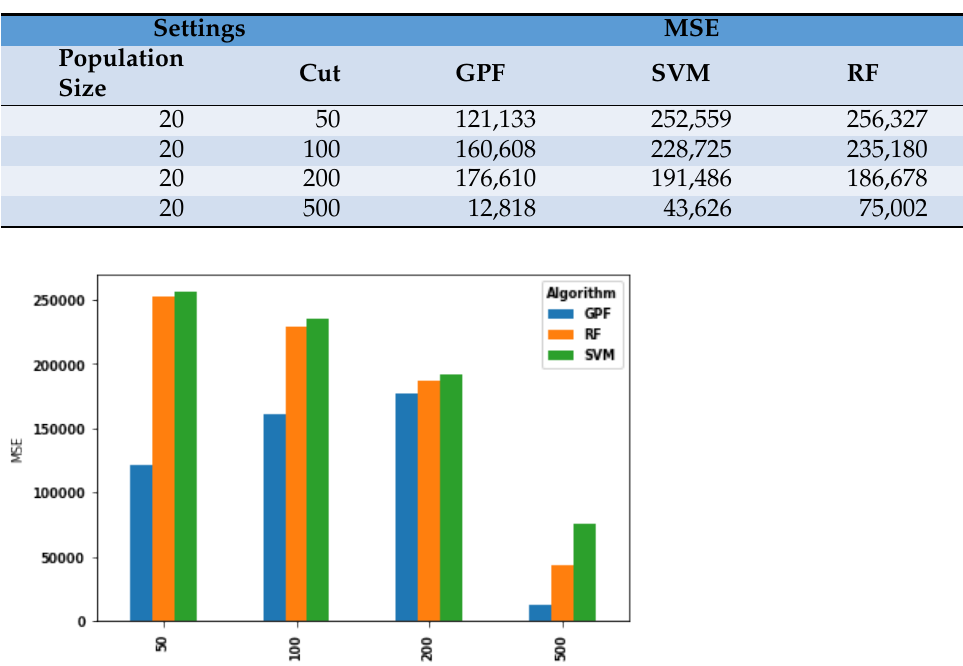
Table 15. MSE of using GPF, only RF or SVM for different cut settings (cut 50, 100, 200, or 500 FC before failure).